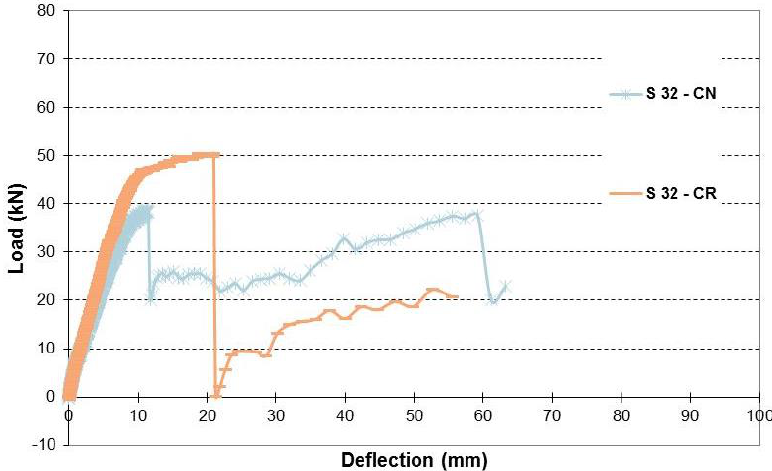
Figure 10. Load-deflection relationship of beams with simulated 20% corrosion level.